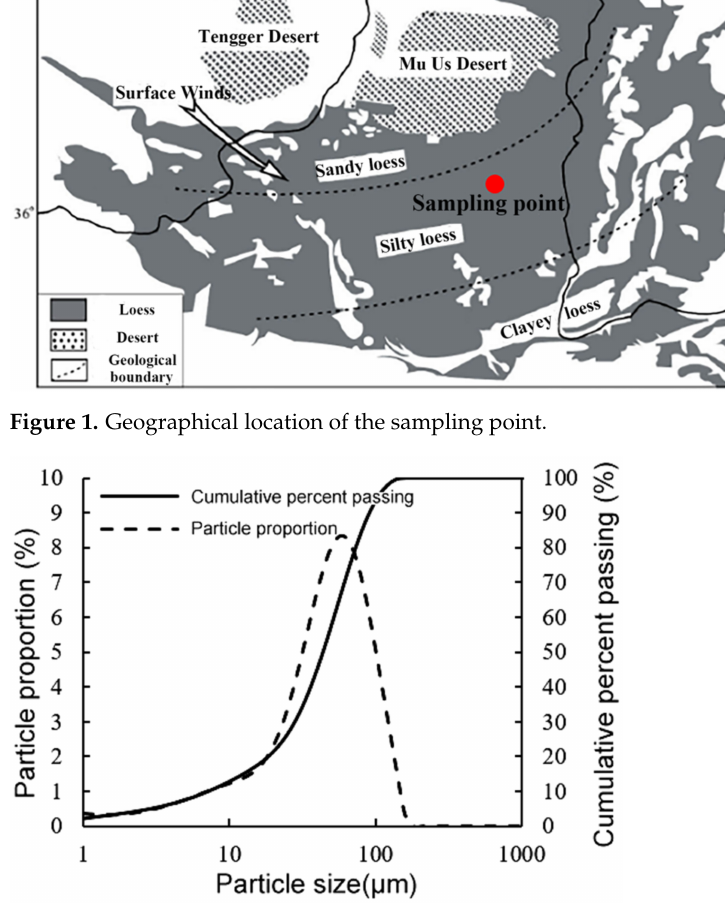
Figure 2. Particle size distribution of Yan’an Loess samples.